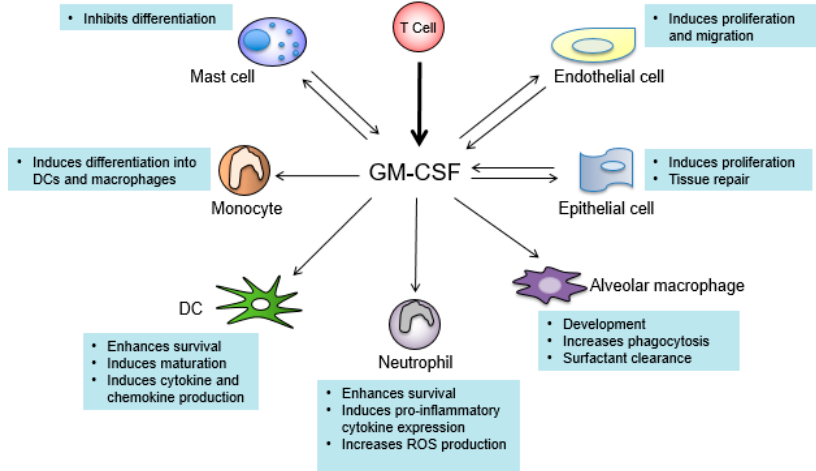
Figure 1. Cell types that produce and respond to granulocyte-macrophage colony-stimulating factor (GM-CSF). Arrows pointing toward GM-CSF indicate cell types that produce GM-CSF. Arrows pointing away from GM-CSF indicate cells that respond to GM-CSF. T cells (bold arrow) are the main producers of GM-CSF. Texts describe the major functions of GM-CSF in the indicated cell types. DC: dendritic cell; ROS: reactive oxygen species.